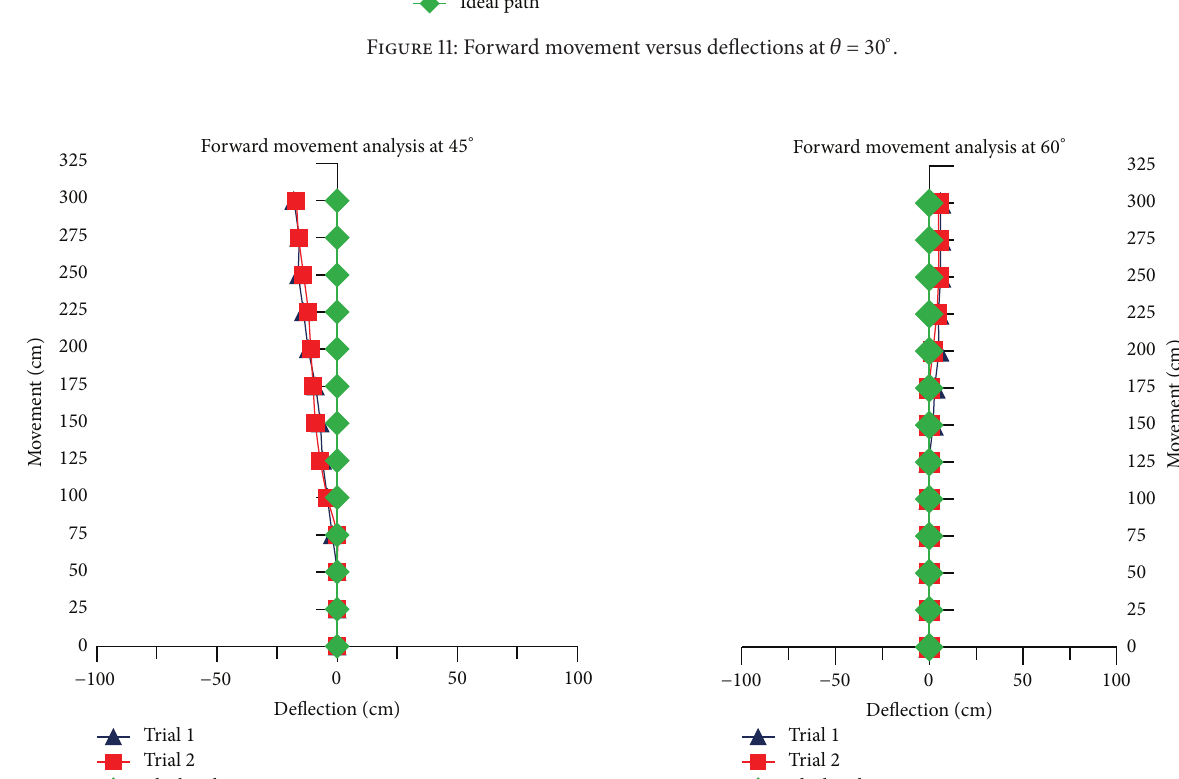
during motion, the effect of friction in working model, and the effect of omniwheel rollers on omniwheel. Irrespective of these errors, TWOMR showed effective movement at angles 120 ∘ and 60 ∘ . Hence, these two angles are optimum angles for the movement of TWOMR, as the deflections